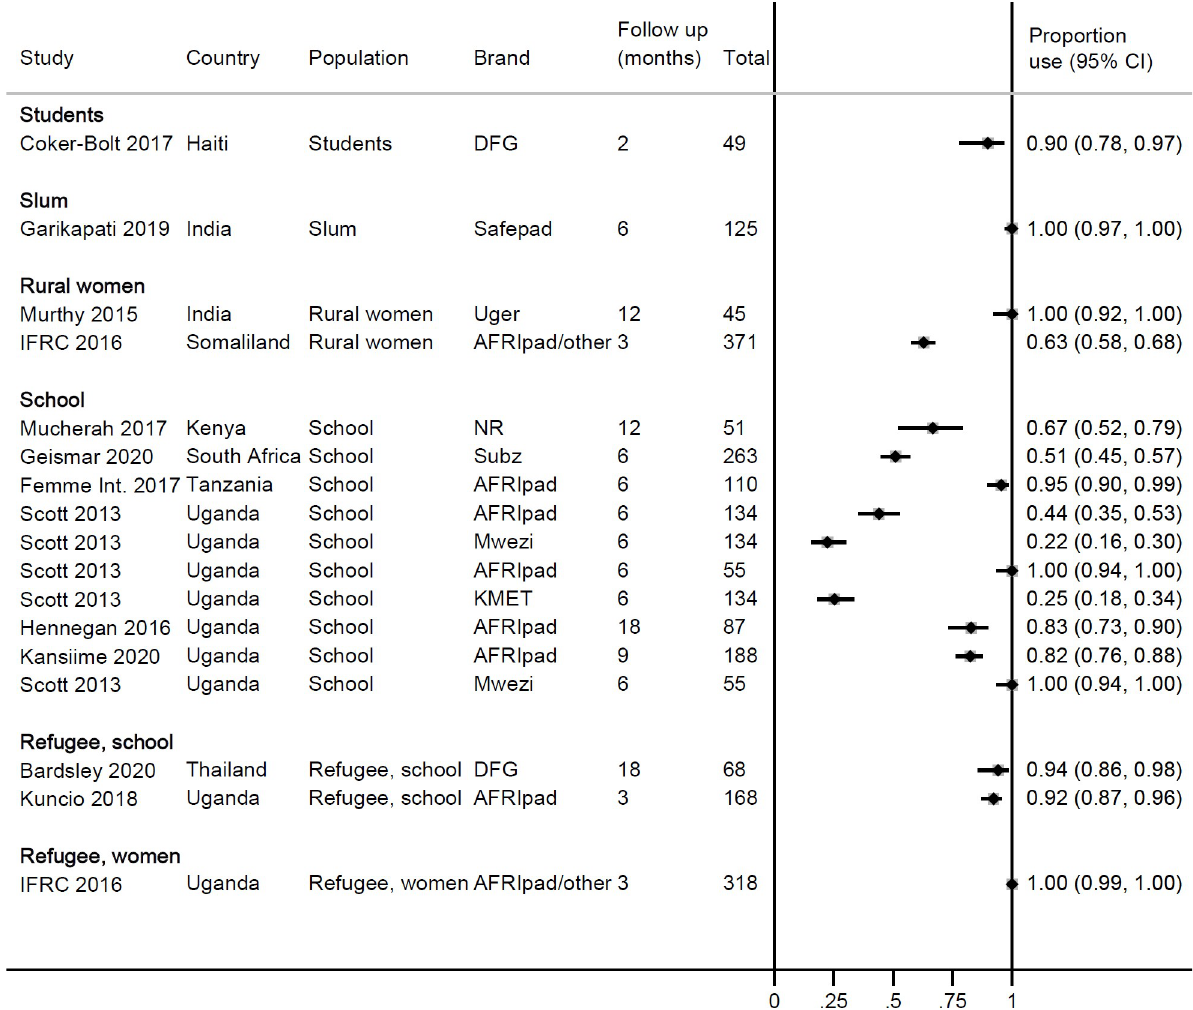
Fig 3. Uptake of reusable pads in cohort studies in middle- and low-income countries, 2014–2019. DFG: Days for Girls. IFRC: International Federation of Red Cross and Red Crescent Societies.